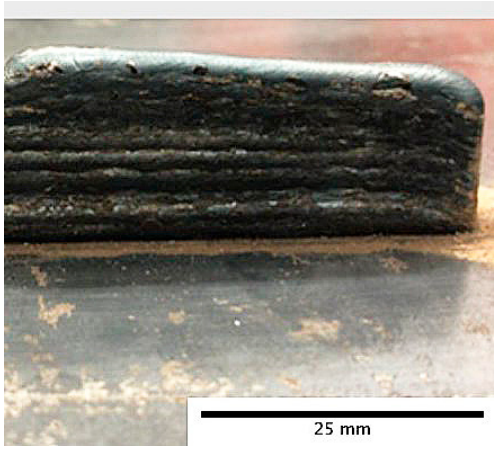
Figure 5. Deposited steel 25-layer wall structure produced with parameter set #8 in Table 3. The test results for Inconel 718 single lines are shown in Table 5. Table 5. Processing parameters and weld bead characteristics for Inconel 718 single pass samples.